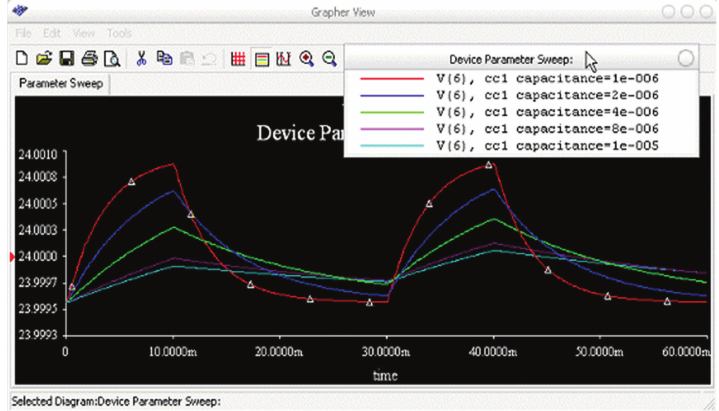
Figure 10: Patterns of output pulse signal of ASSA for a one body order simulation system.